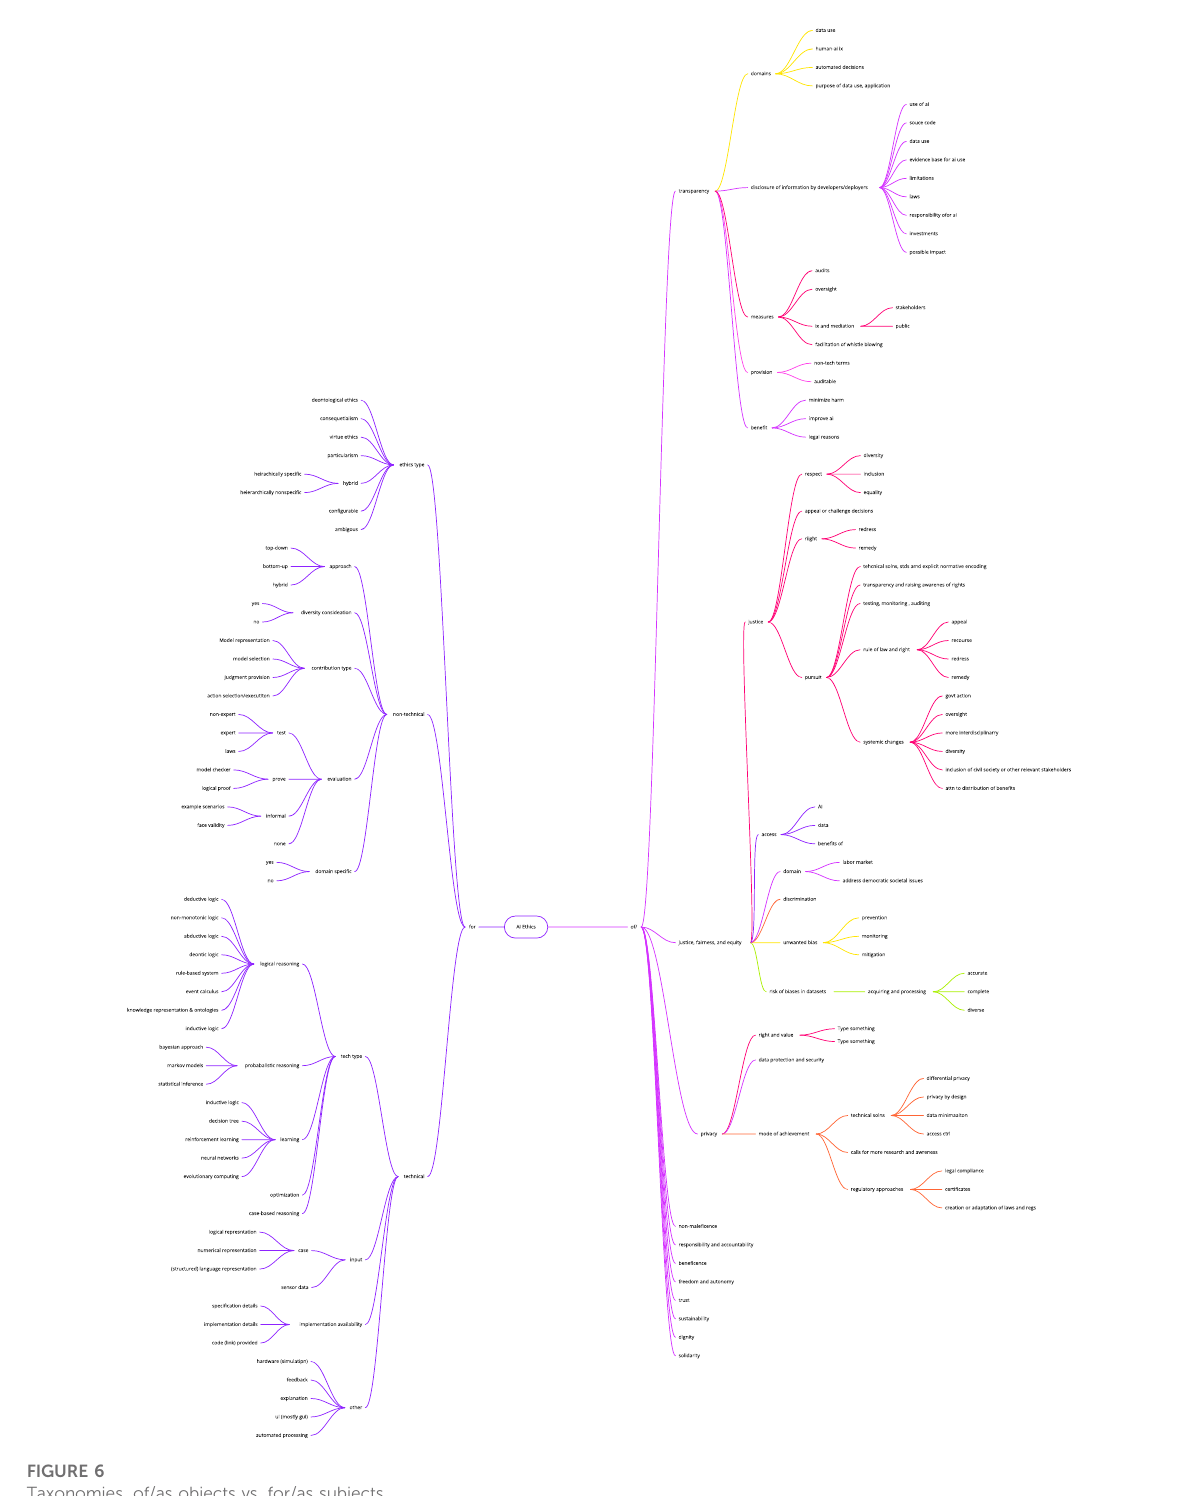
FIGURE 6 Taxonomies, of/as objects vs. for/as